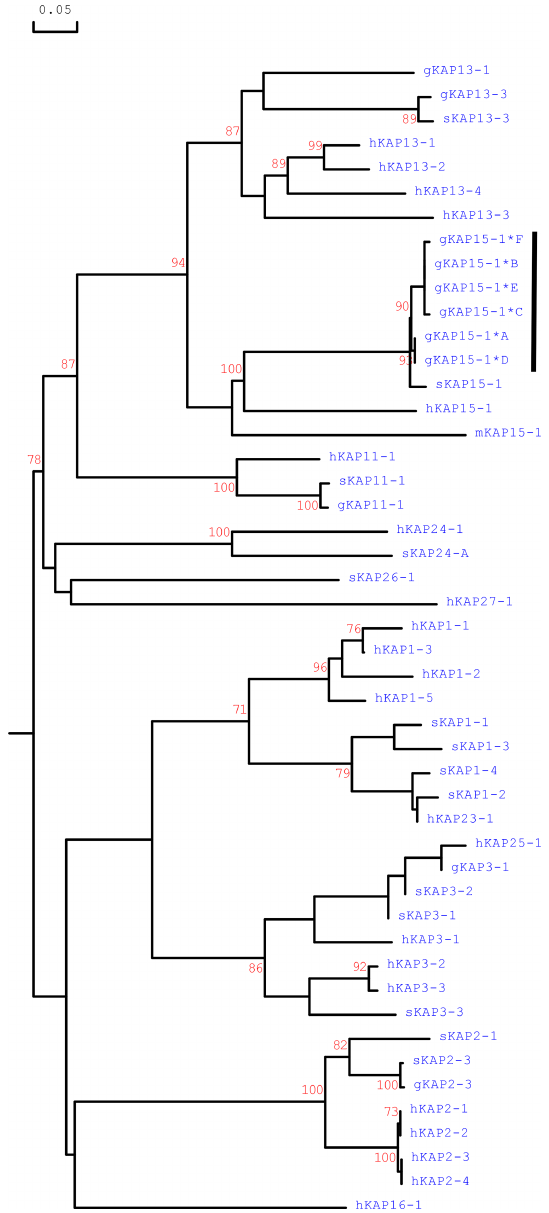
Figure 4. Phylogenetic tree of HS-KAPs from goats, sheep, humans and mice. The tree was constructed using the amino acid sequences or the predicted amino acid sequences. The caprine KAPs are indicated with a prefix “g”, while the sequences of sheep, humans and mice are indicated with prefix “s”, “h” and “m”, respectively. The numbers at the forks indicate the bootstrap confidence values and only those equal to or higher than 70% are shown. The newly identified caprine KAP15-1 sequences are indicated with a horizontal bar, and the GenBank accession numbers for other HS-KAPs are NM_001285774 (gKAP3-1), NM_001285767.1 (gKAP11-1), AY510115